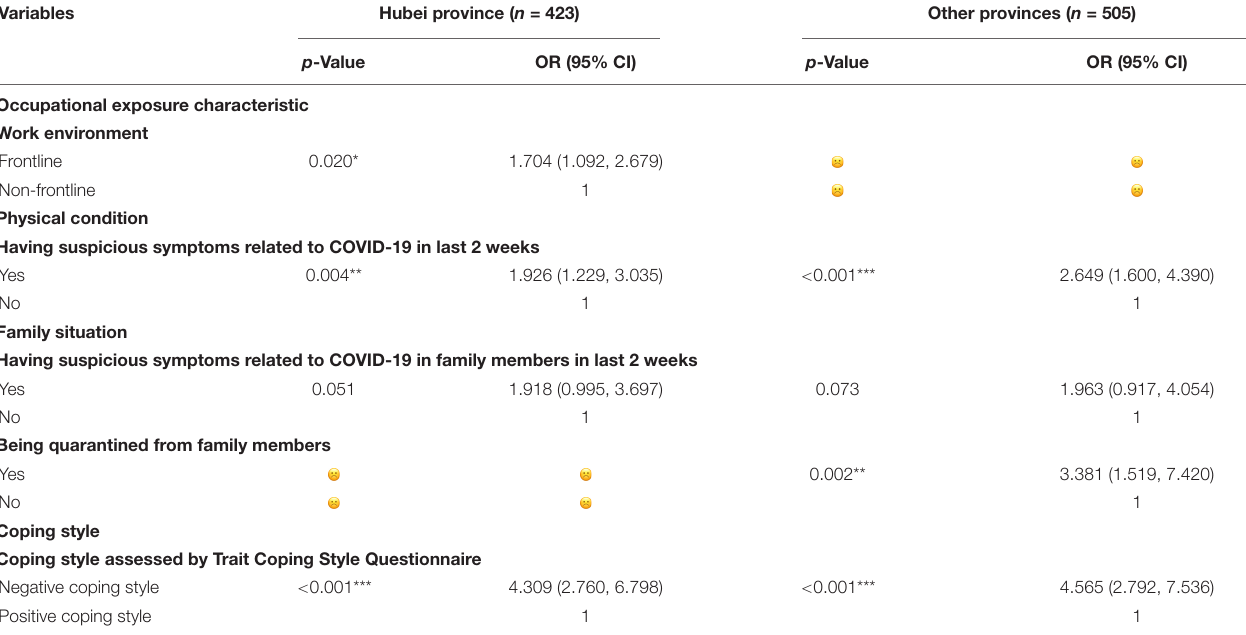
TABLE 3 | Two separate multiple logistic regression analysis with risk factors for ADSs in Hubei province (C statistic = 0.720) and other provinces (C statistic =